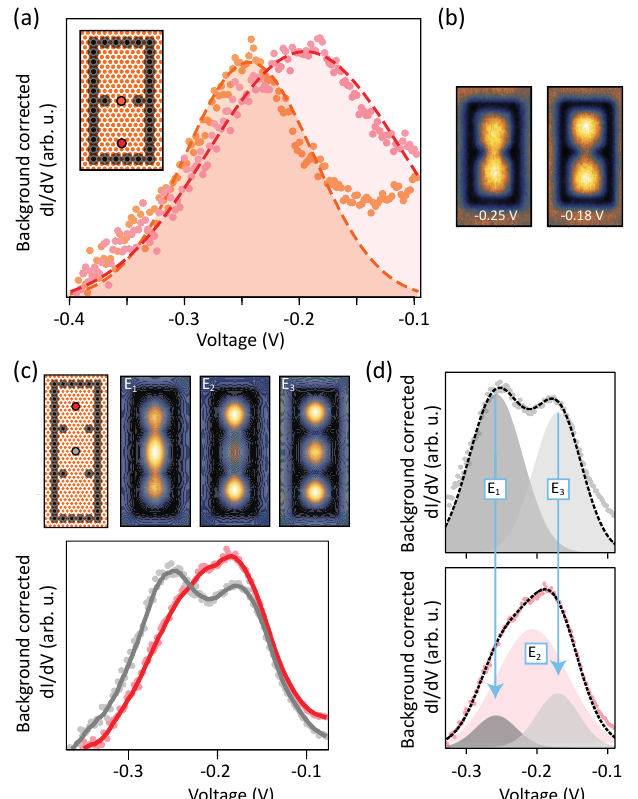
Figure 5: (a) dI spectra on two different positions of a dimer. Locations indicated dV by dots in the inset. (b) Differential conductance maps were acquired at the approx- imate energies where the maxima of the peaks lie. (c) Bottom: dI spectra acquired dV at the positions shown in corresponding colors in the top left diagram. LDOS maps = -0.26 eV, E = -0.22 eV, E = -0.18 eV, respec- (from muffin tin calculations) at E 1 2 3 tively. (d) Gaussian fitting procedure applied to the same two spectra to find the energies of interest. The shaded regions in each plot represent the individual Gaus- sians, which when summed, lead to the curves represented by dashed lines. The centers of the Gaussians correspond to E , E and E 1 2 3